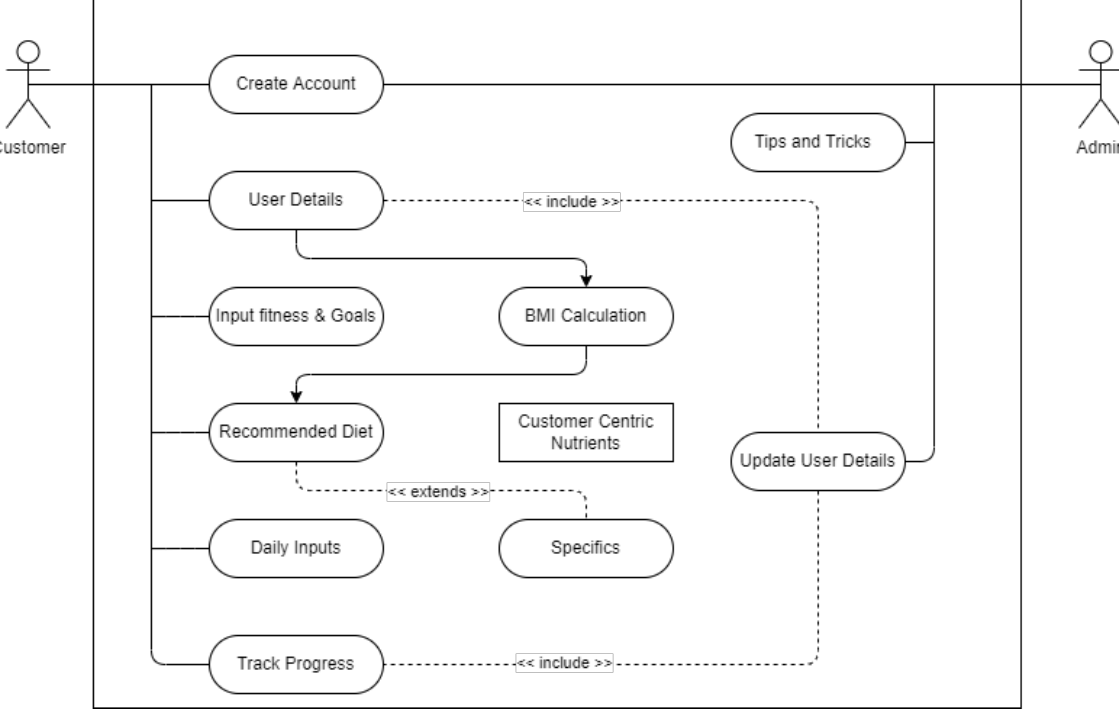
Figure 16. Use Case Diagram of the proposed